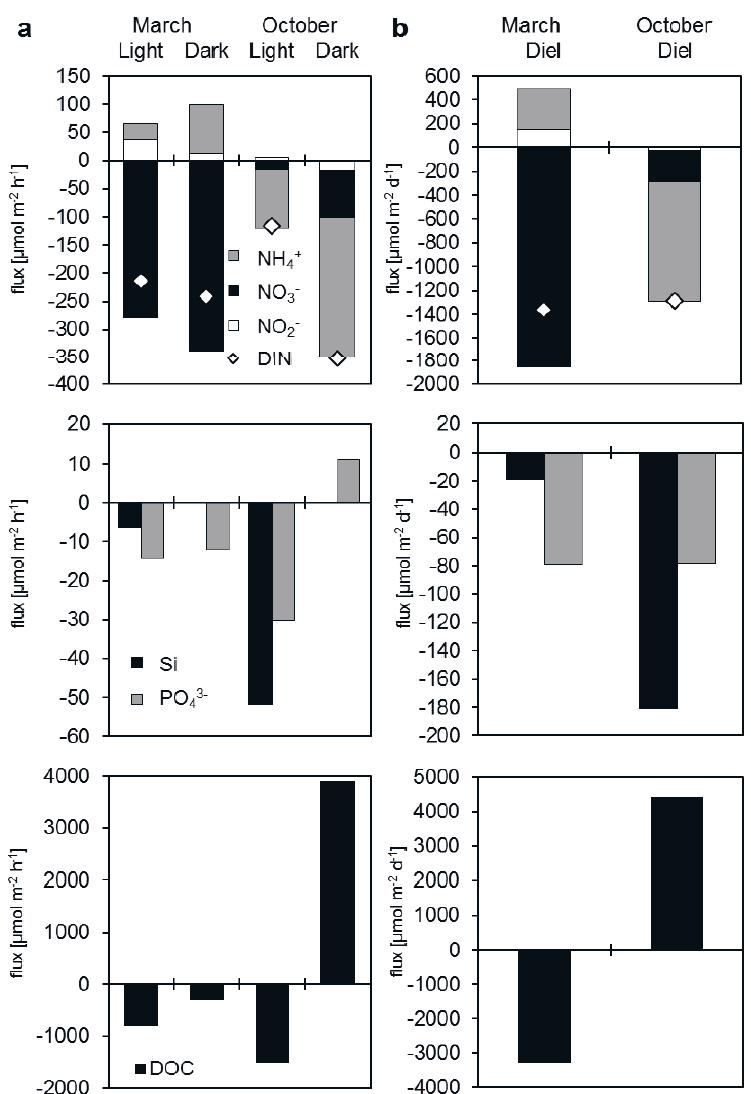
Figure 6. Total sediment fluxes of dissolved nutrients; ( a ) hourly [ μ mol·m − 2 ·h − 1 ]; and ( b ) diel [ μ mol·m − 2 ·day − 1 ]. Dissolved inorganic nitrogen (DIN) flux is calculated as the sum of nitrate (NO 3 − ), nitrite (NO 2 − ), and ammonium (NH 4+ ) fluxes. Diel fluxes are based on an inundation time of 6 h per